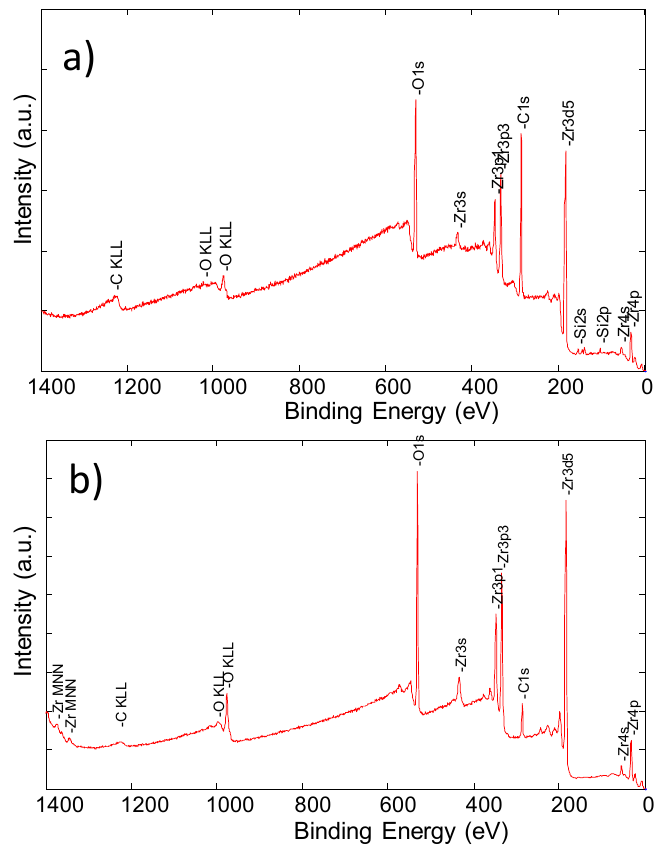
Figure 8. Survey spectrum of the ZrO 2 layer obtained ( a ) “as received” and ( b ) after cleaning by Ar+ ion treatment in UHV conditions.